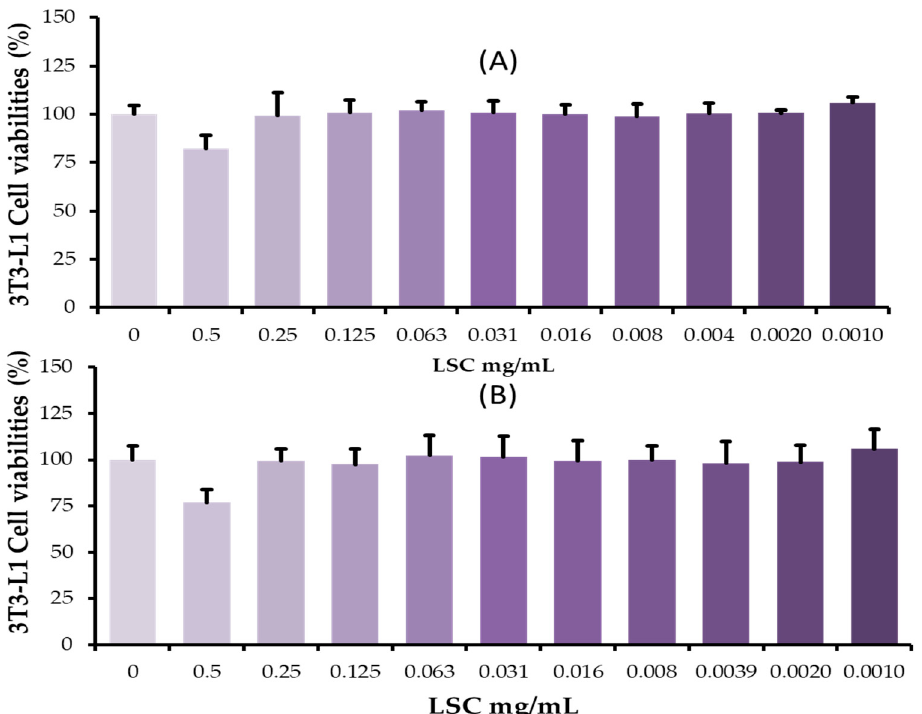
Figure 1. Effects of L. citreum cell-free supernatants on 3T3-L1 cells. Cells were incubated with different concentrations of LSC under normal cell culture conditions. After 24 h and 48 h, EZcytox reagent was used to determine cell viability. ( A ) Percentage of viable cells in experimental groups at 24 h; ( B ) Percentage of viable cells at 48 h. Data are expressed as mean (SD) of fi ve replicates.